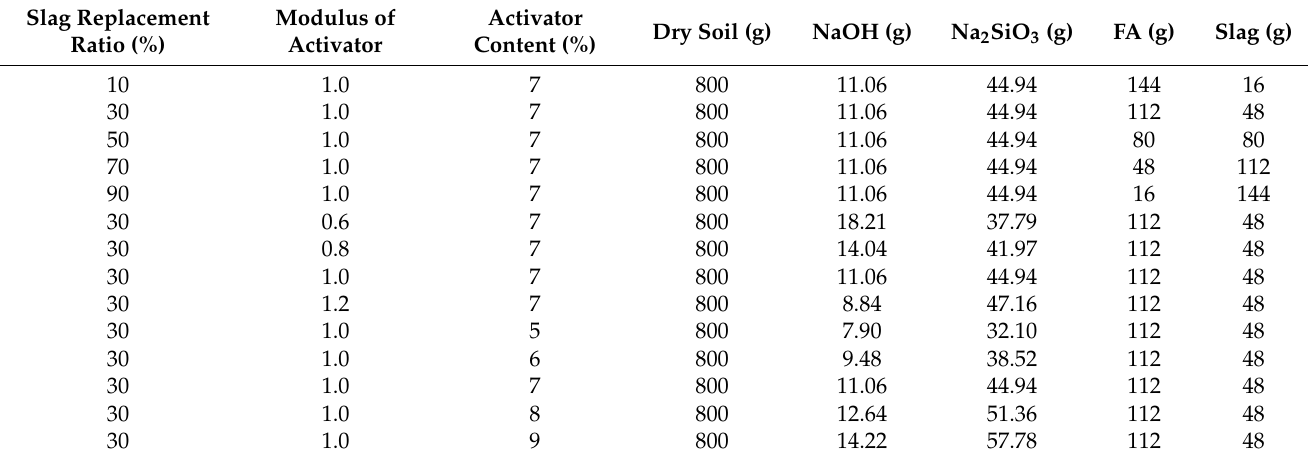
Table 4. Testing schemes.